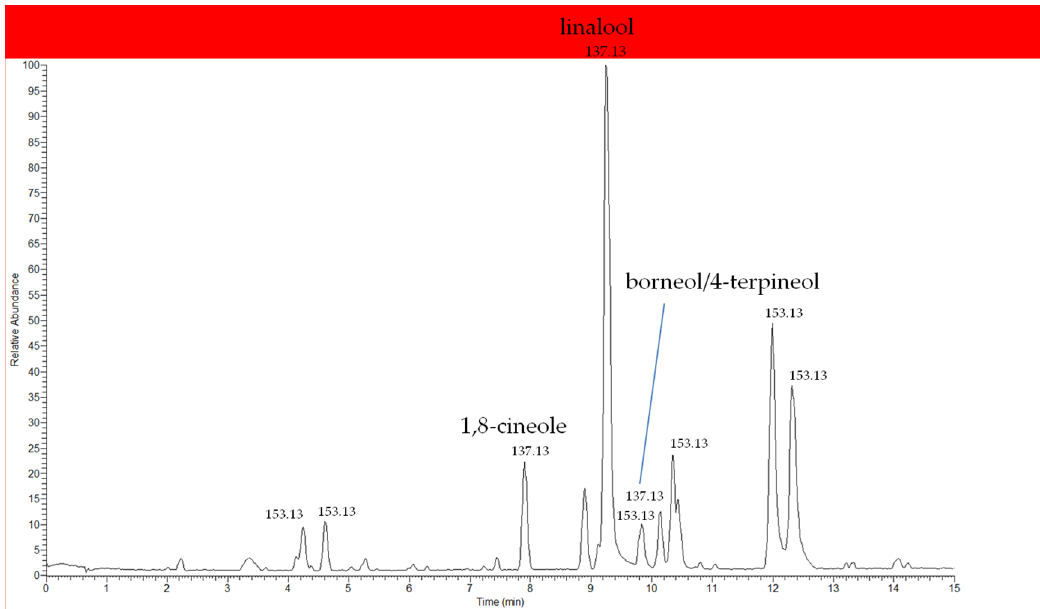
Figure 2. Ultra High Performance Liquid Chromatography (UHPLC)-MS (total ion current) chromatogram of Lavandin flower aromatic water, showing oxygenated monoterpenes, tentatively identified among the most abundant components as linaool, 1,8-cineole and borneol/ 4-terpineol.